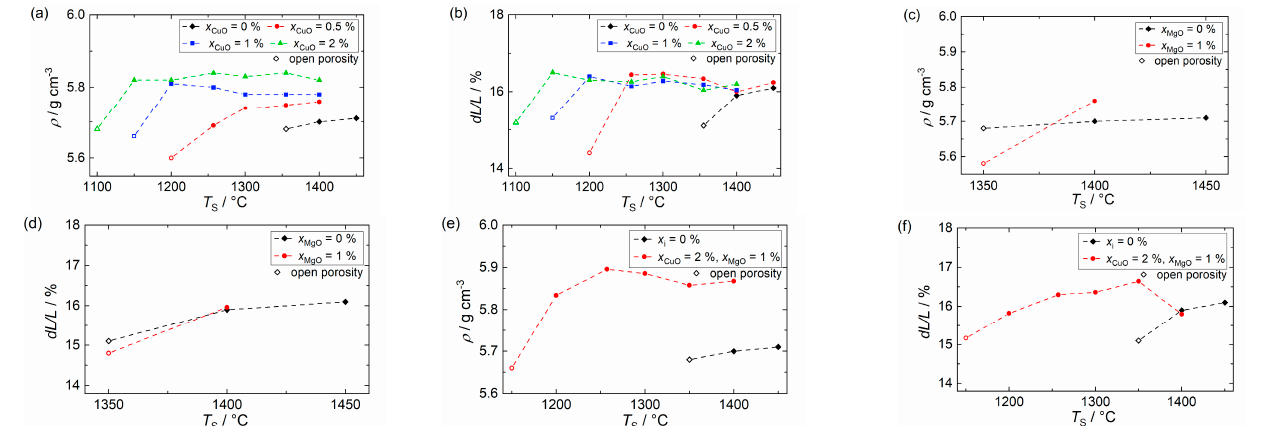
Figure 1. Bulk density and shrinkage of BSSnT-18-6.5 bulk ceramics with addition of CuO ( a , b ), MgO ( c , d ) and CuO and MgO ( e , f ).